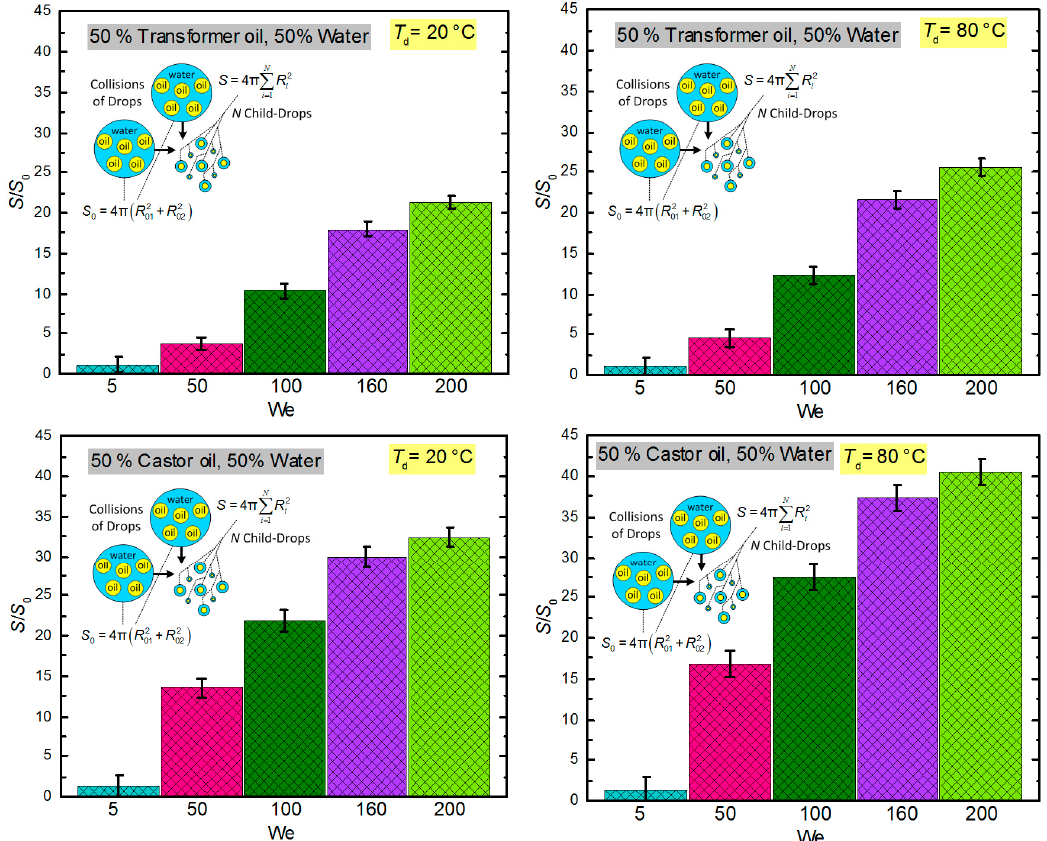
Figure 7. The results of additional test experiments (carried out in accordance with the methods [34,35]) with droplets of oil–water emulsions.